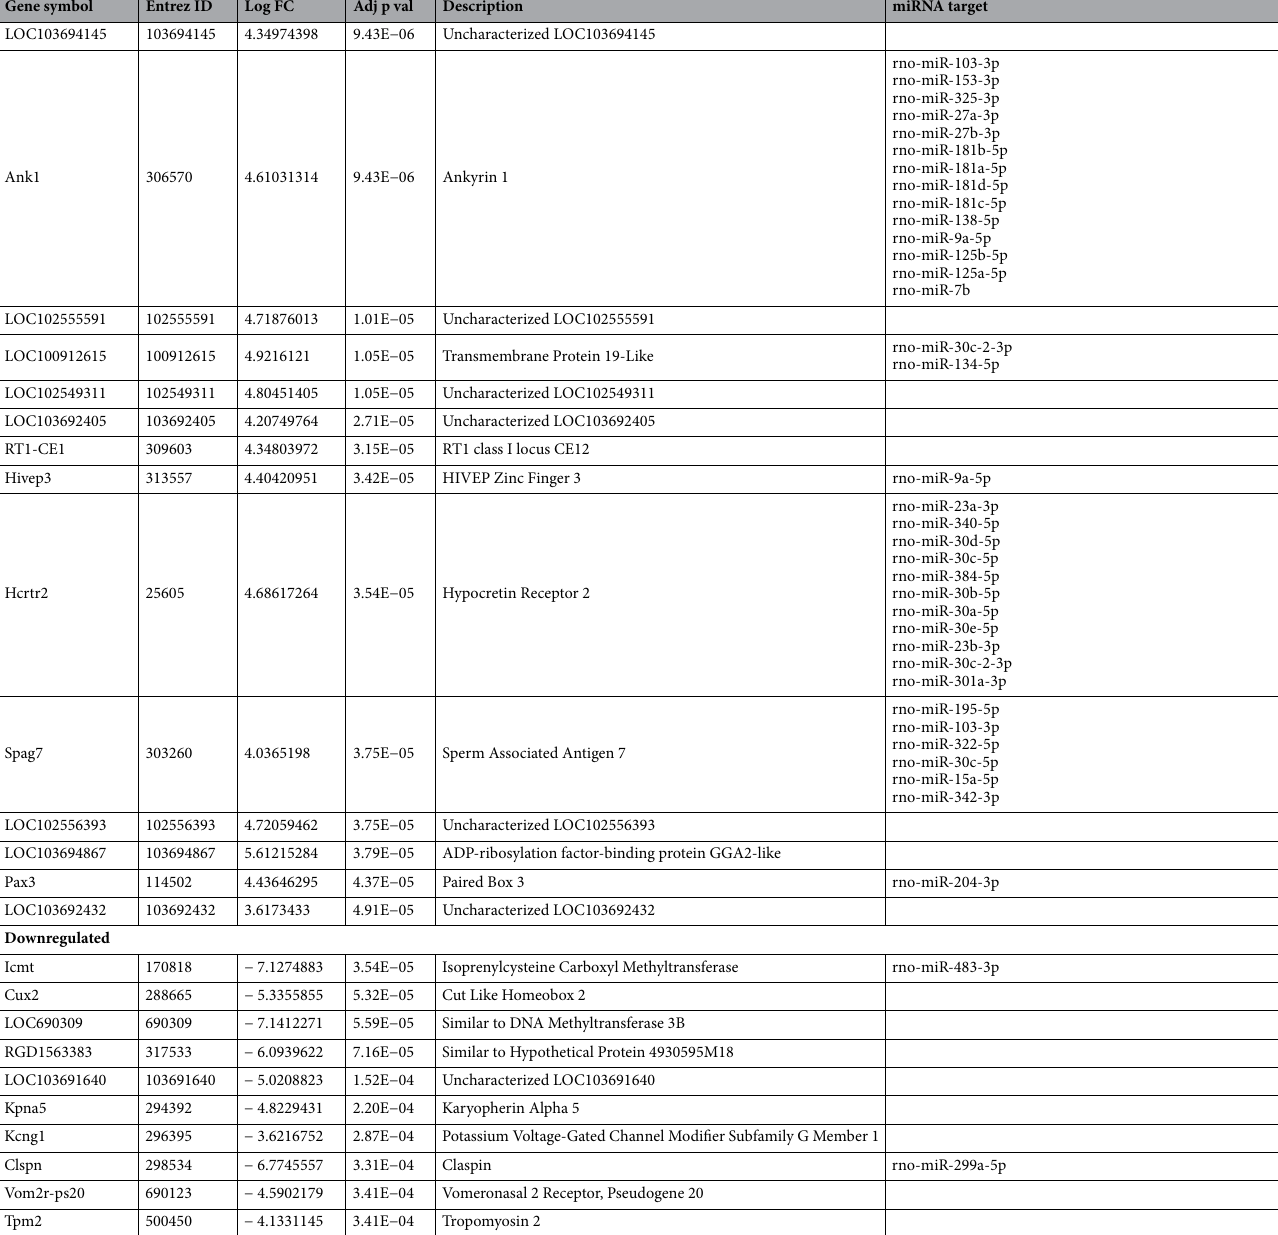
Table 2. Topmost DEGs and their predicted miRNA targets following microarray expression analysis. Most significant upregulated and downregulated DEGs following perinatal (a) nicotine-alcohol exposure on